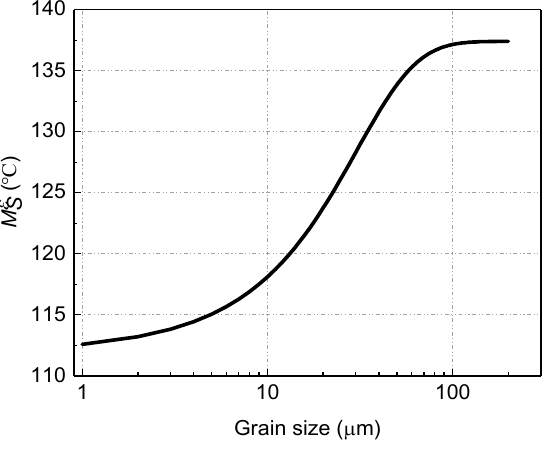
Figure 15. Variation of Ms with the change of grain size.